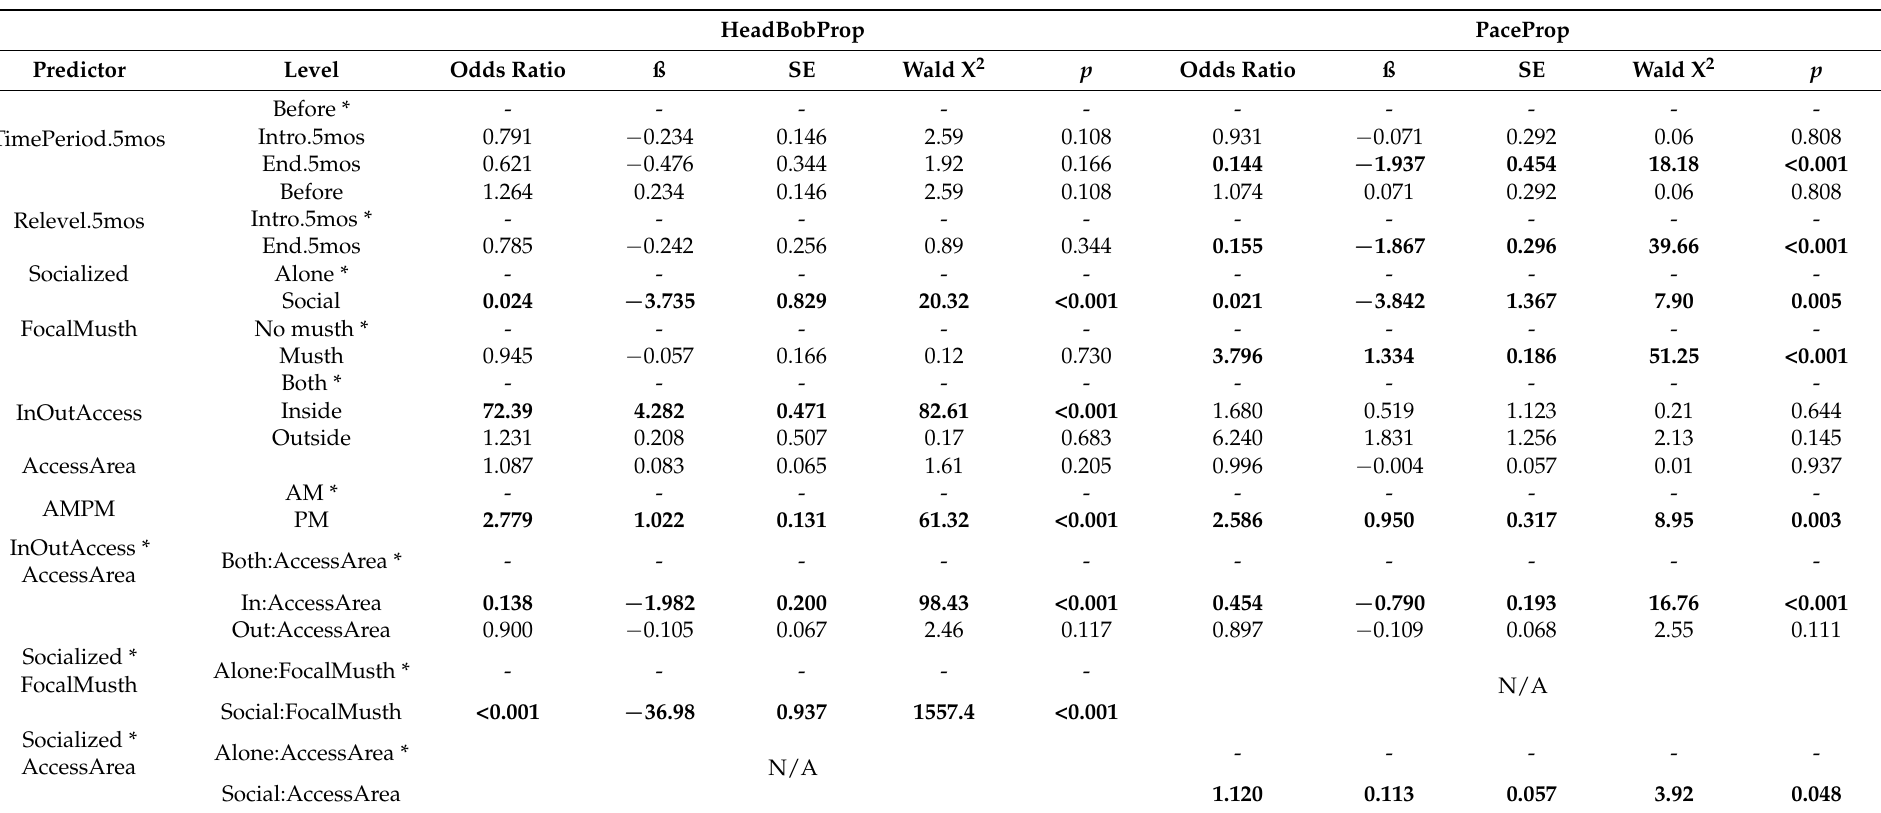
Table 6. GEE Model Parameter Estimates for All Data (Alone and Social). Generalized Estimating Equation Results of Associations between Predictor Variables (Fixed Effects) and Stereotypic Behavioral Response